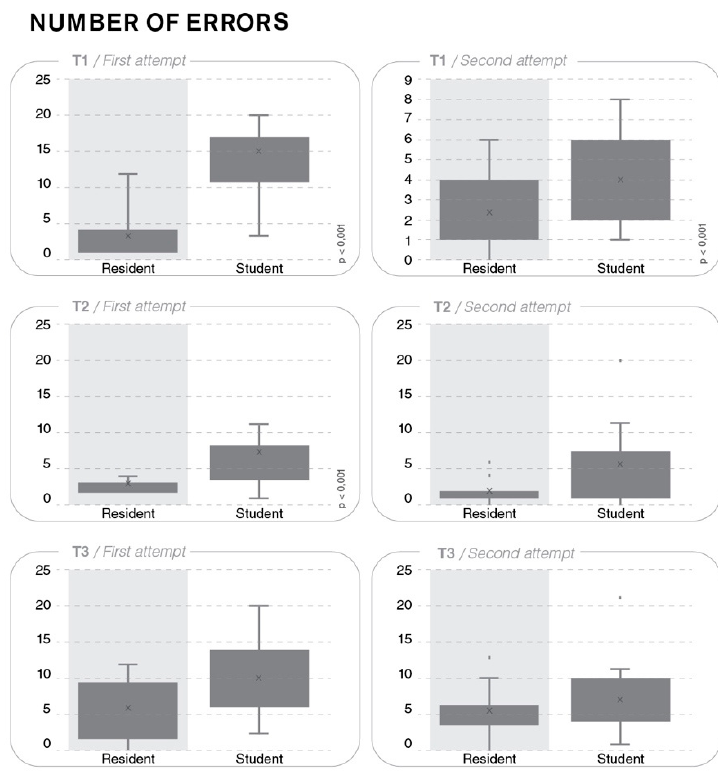
Figure 4. Mean number of procedural errors ( ± SD) for T1–T3.